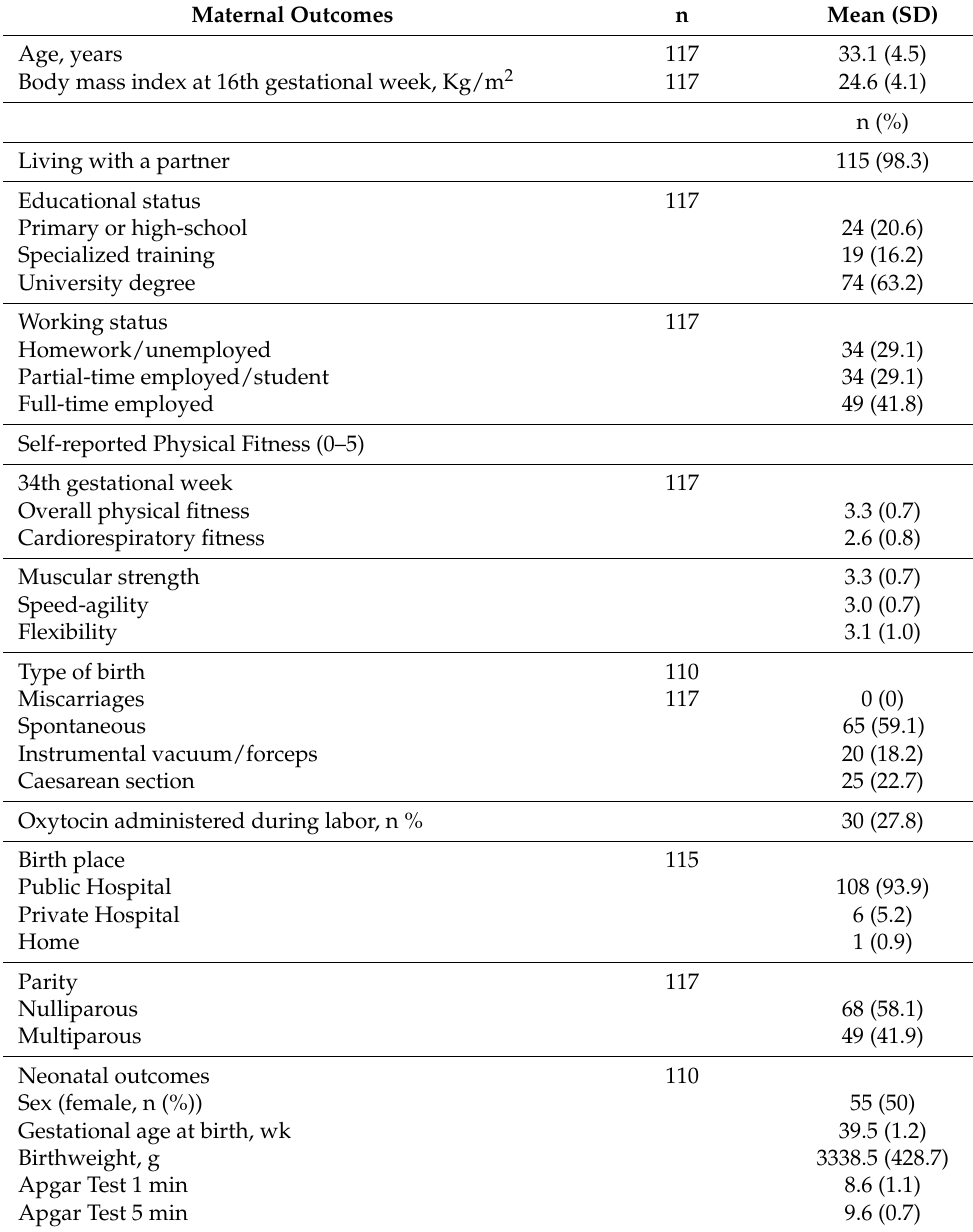
Table 1. Sociodemographic and clinical characteristic of the study sample (n =